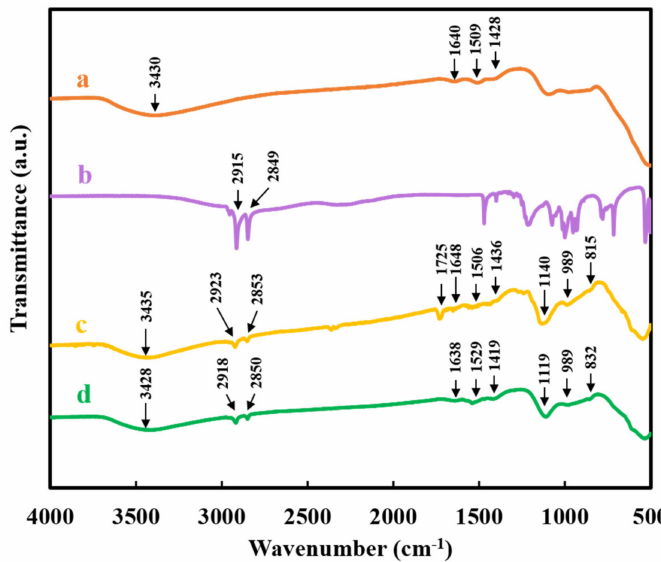
Figure 8. FTIR spectra of the ( a ) as-precipitated Al(OH) 3 , ( b ) as-received HDPA, ( c ) PMMA-Al(OH) 3 coating, and ( d ) Al(OH) 3 extracted using